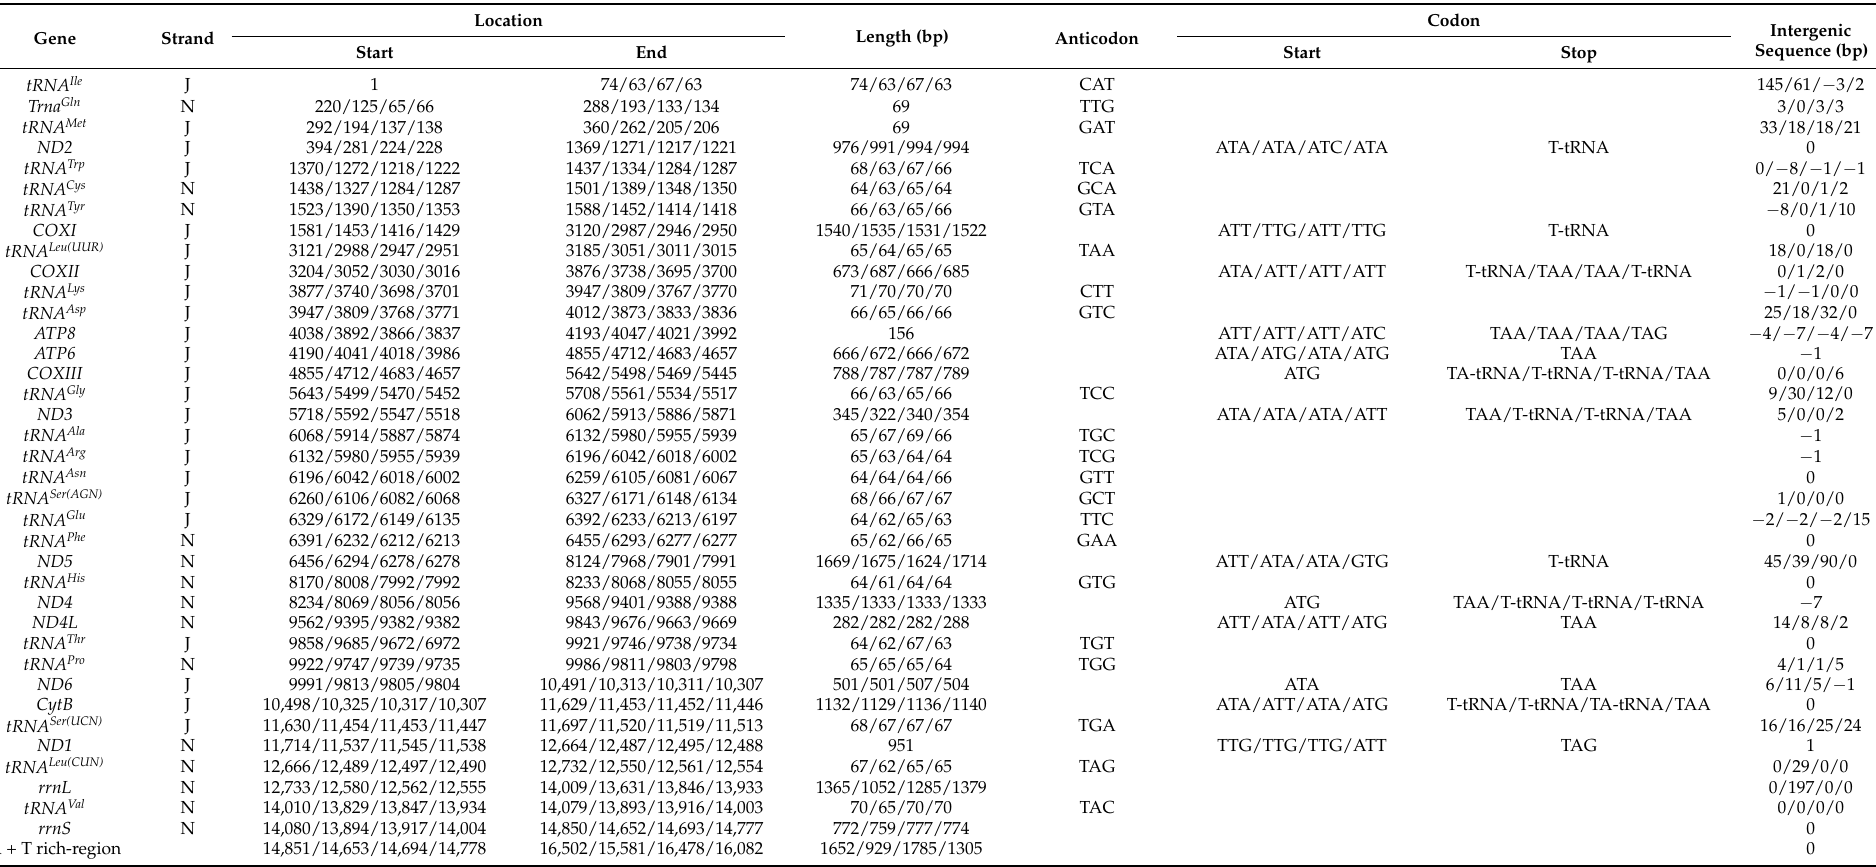
Table 2. Annotation of the mitochondrial genome of T. metasobrina , E. opaca , N. arisana , and Languriinae